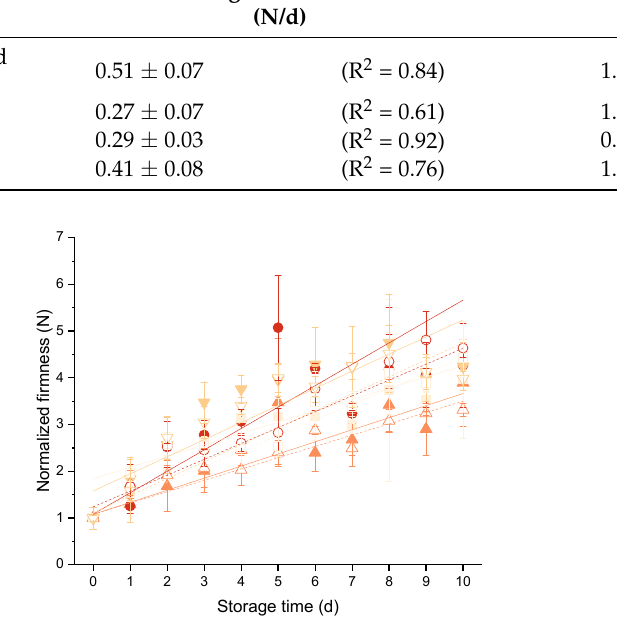
Table 3. Absolute firming rates for different storage conditions and bread types. The results are shown in the table in terms of the firming rate (N/d, increase in firmness per day of storage), defined as the slope of the linear model (x ± STD, n = 3). Absolute Firming Rate of Pan Wheat Bread Absolute Firming Rate of Mixed-Type (N/d) Sourdough Bread (N/d) PE-layered microperforated paper bag (21.3 ± 0.4 ◦ C)